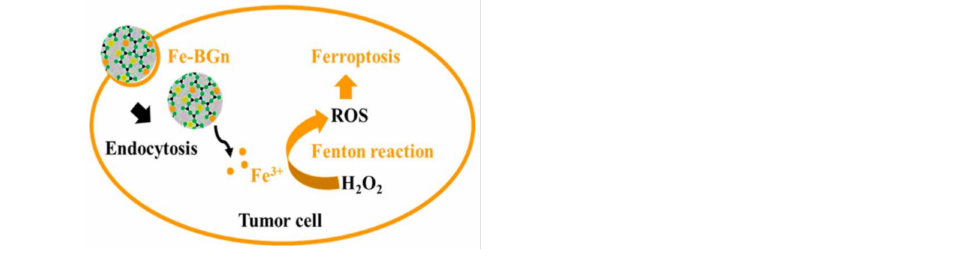
Figure 7. Application of Fe-MBG for ferroptosis-based cancer therapy. Reproduced with some modifications from ref [142]. Copyright 2021